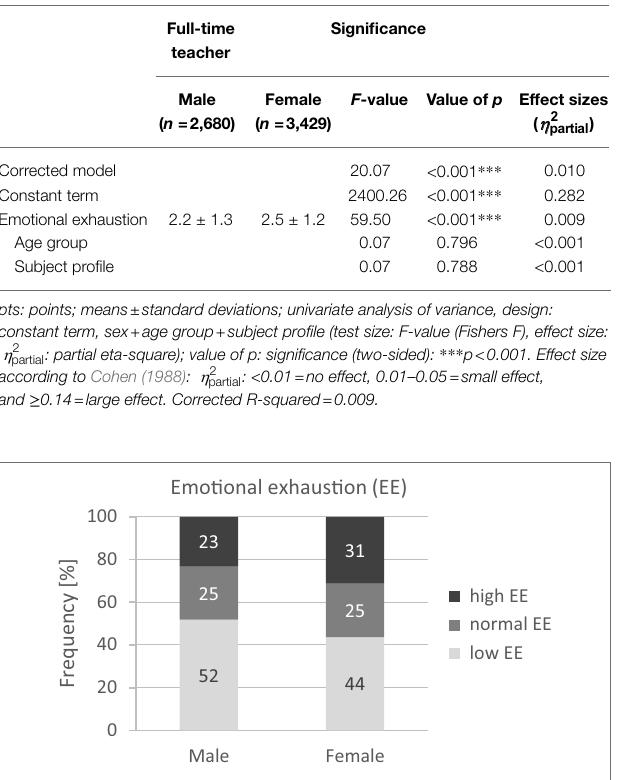
FIGURE 2 | Emotional exhaustion of male ( n = 2,680) and female ( n = 3,429) full-time teachers. Chi-square test according to Pearson (test size: χ 2 -value, effect size: d); significance (two-sided). Effect size according to Cohen (1988): d : <0.20 = no effect.